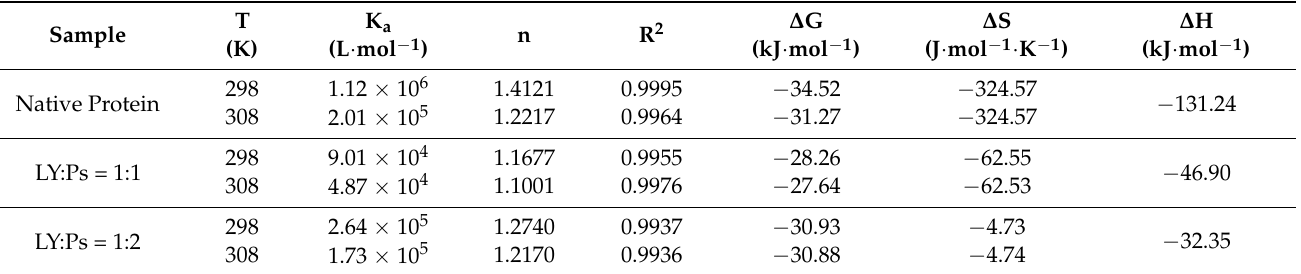
Table 1. Binding parameters of EGCG-lysozyme, EGCG-nanoparticles, and thermodynamic parameters of the binding procedure.